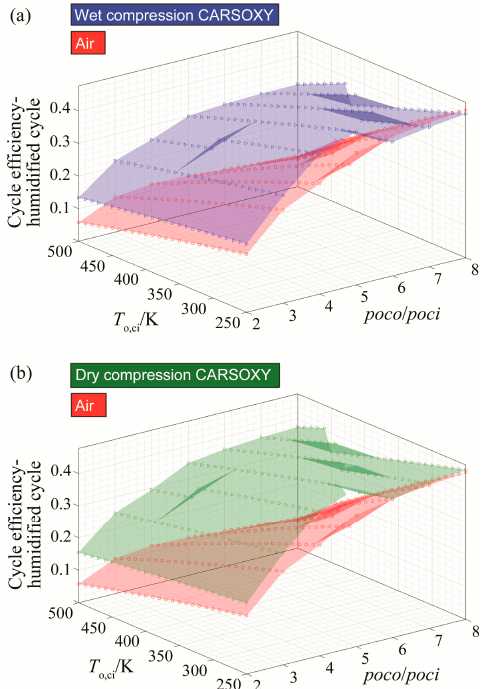
Figure 5. Efficiency results for the evaporative cycle using ( a ) wet compression and ( b ) dry compression.